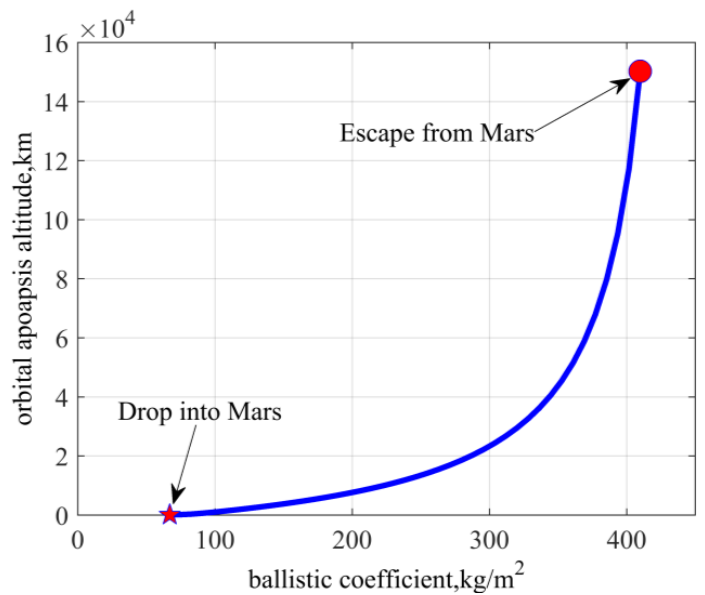
Figure 4. Orbital apoapsis altitude after aerocapture vs. ballistic coefficient.